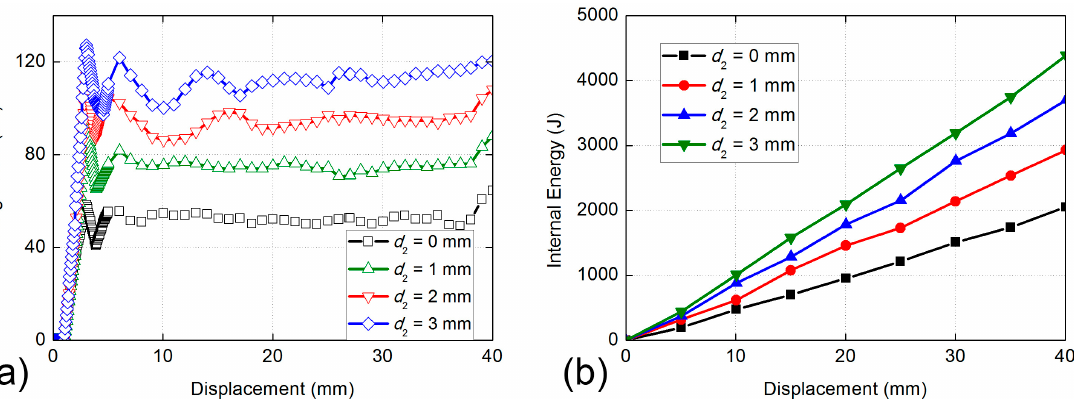
Figure 13. Comparisons of absorbed energy properties of BHS-2 with different filling honeycombs size: ( a ) crushing force versus displacement curves; ( b ) absorbed energy versus displacement curves. Table 3. Energy absorbing behaviors of BHS-2 with different filling cell sizes.